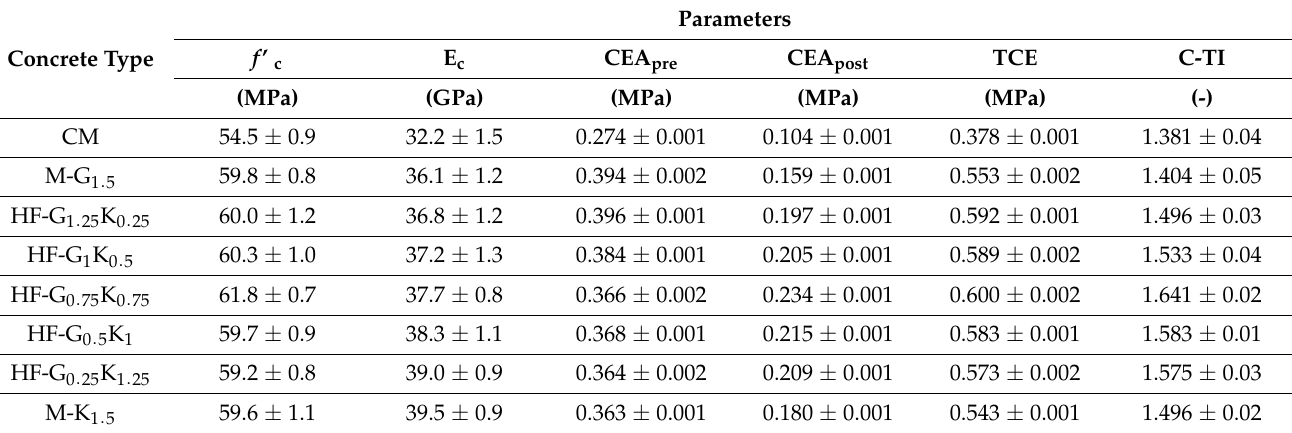
Table 8. Properties of concrete during